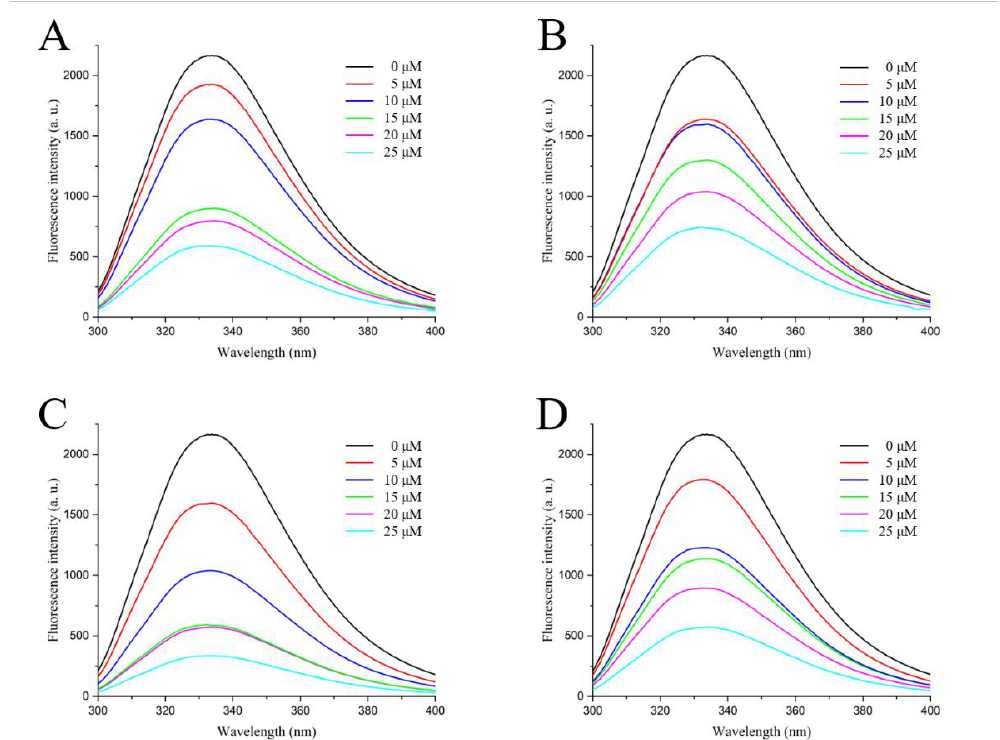
Figure 3. Fluorescence spectra of active compounds (( A ): Procyanidin, ( B ): Stevioside, ( C ): Troxerutin,